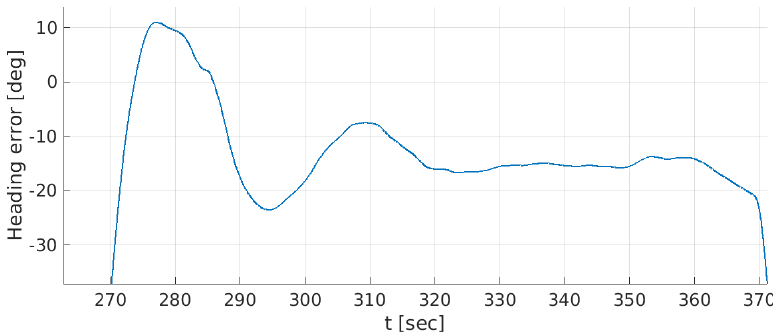
Figure 25. Heading error, employing the SPARUS II configuration along a single